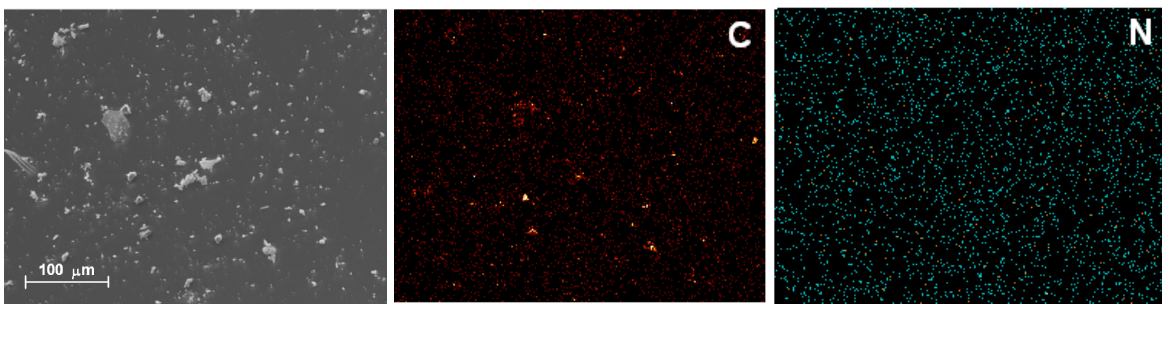
Figure 5. HPDEC 29 Si-RMN spectra of the xerogels with the H covalently bonded, through the use of NAEPTES, to the pore walls of silica organically modified with organic groups coming from the use of 1% v/V